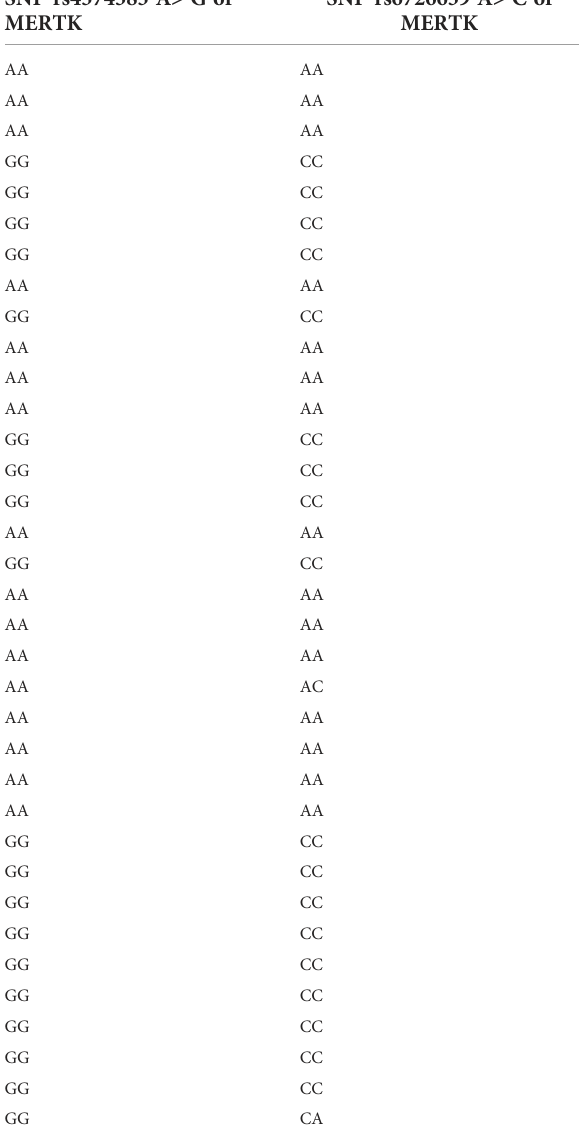
TABLE 3 Distribution of MERTK rs4374383 and rs6726639 SNPs in CHC patients selected for MERTK and downstream pathways panel. SNP rs4374383 A> G